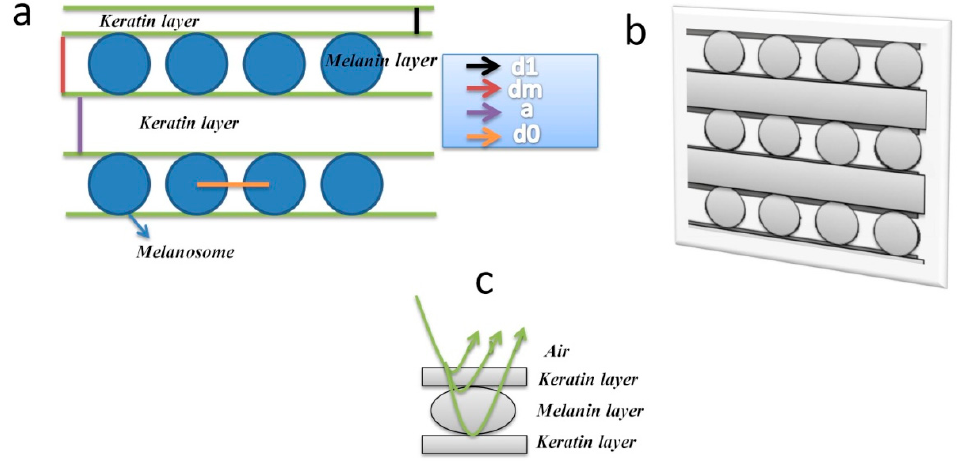
Figure 1. ( a ) Passeriformes feathers' multilayer elements such as the keratin layer, melanin layer, and melanosome; d1, dm, a, and d0 are the symbols of first keratin layer thickness (adapted from [23]), melanin layer thickness, and subsequent keratin layers' thicknesses, which corresponds to melanosomes’ diameters, and the distance between melanosome layers [24], respectively. ( b ) A barbules model was created in the electromagnetic simulation software CST (Computer Simulation Technology) to perform the light interaction with barbules [11]. ( c ) A schematic of light reflection through the feather’s multiple layers is shown here. Table 1. The thickness of different layers in the simulated feather